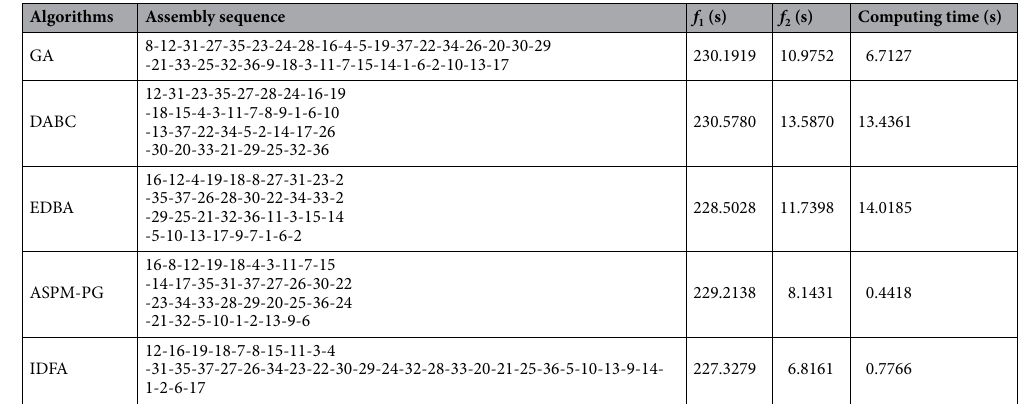
Table 7. Performance analysis of 5 algorithms. f 1 is the total working time (s) and f 2 is the load balancing (s).